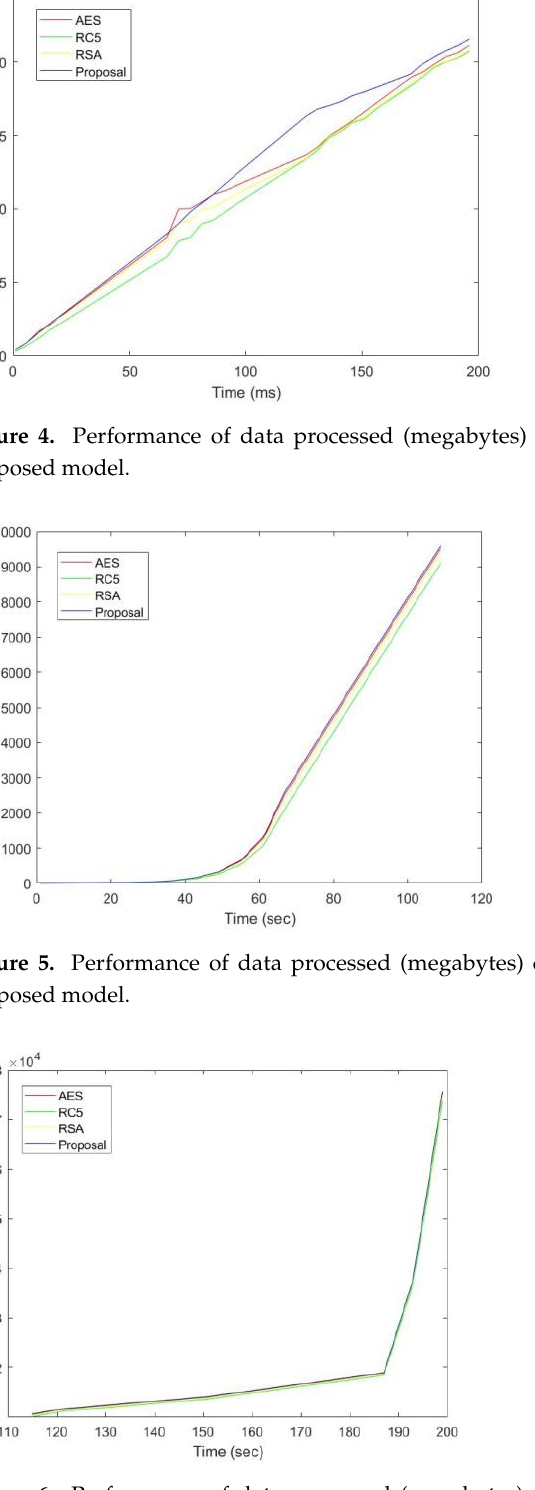
Figure 6. Performance of data processed (megabytes) comparison of the AES, RC5, RSA, and proposed model.